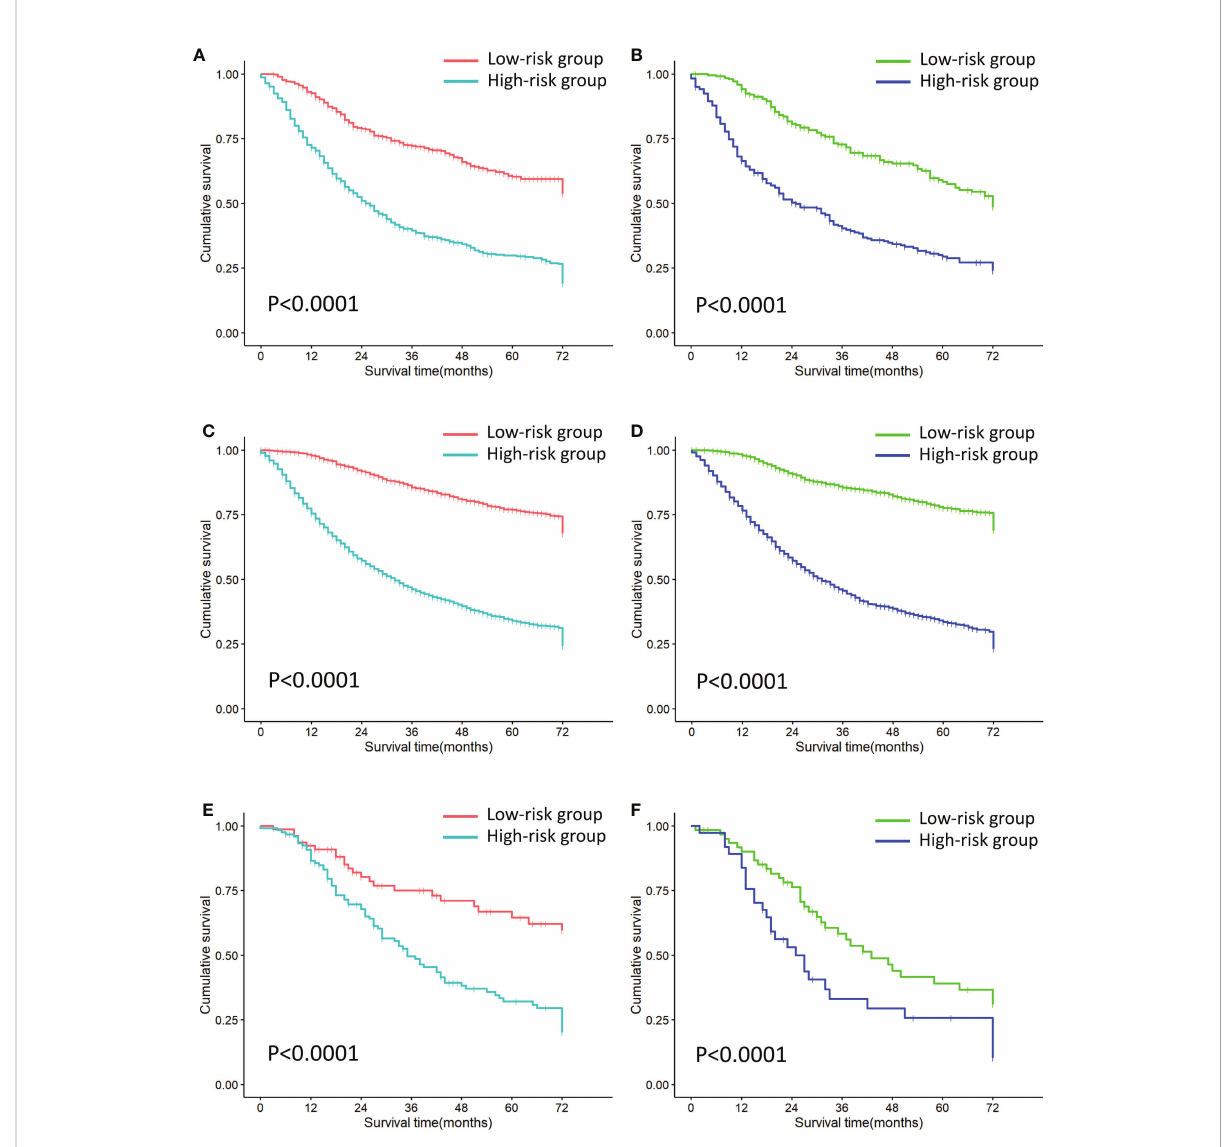
FIGURE 8 Risk strati fi cation of all cohorts. (A) Risk strati fi cation of the fi rst cohort training set. (B) Risk strati fi cation of the fi rst cohort validation set. (C) Risk strati fi cation of the second cohort training set. (D) Risk strati fi cation of the second cohort validation set. (E) Risk strati fi cation of the third cohort training set. (F) Risk strati fi cation of the third cohort validation